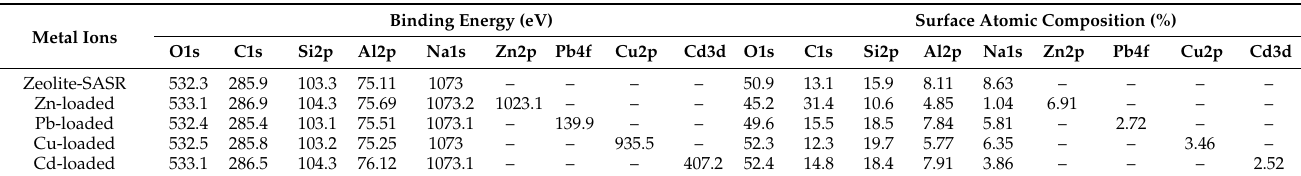
Table 7. Binding energy and contents of elements on synthesized zeolite surface.